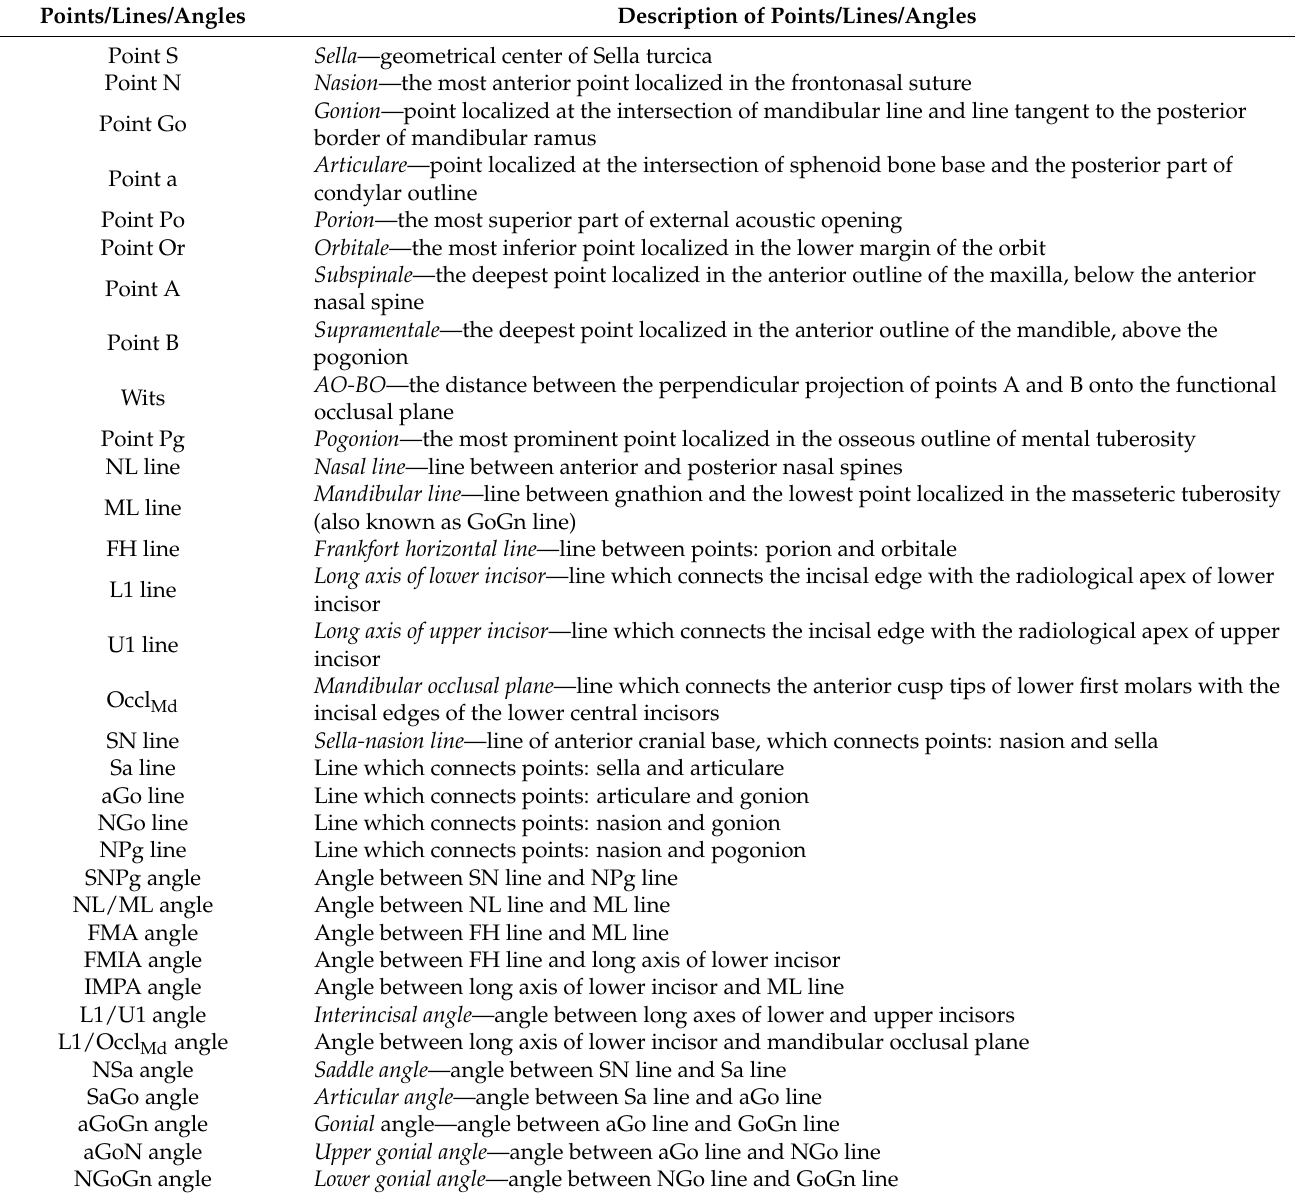
Table 2. List of points, lines and angles used to analyze the mandibular position and morphology, as well as the position of lower incisors on the basis of the literature